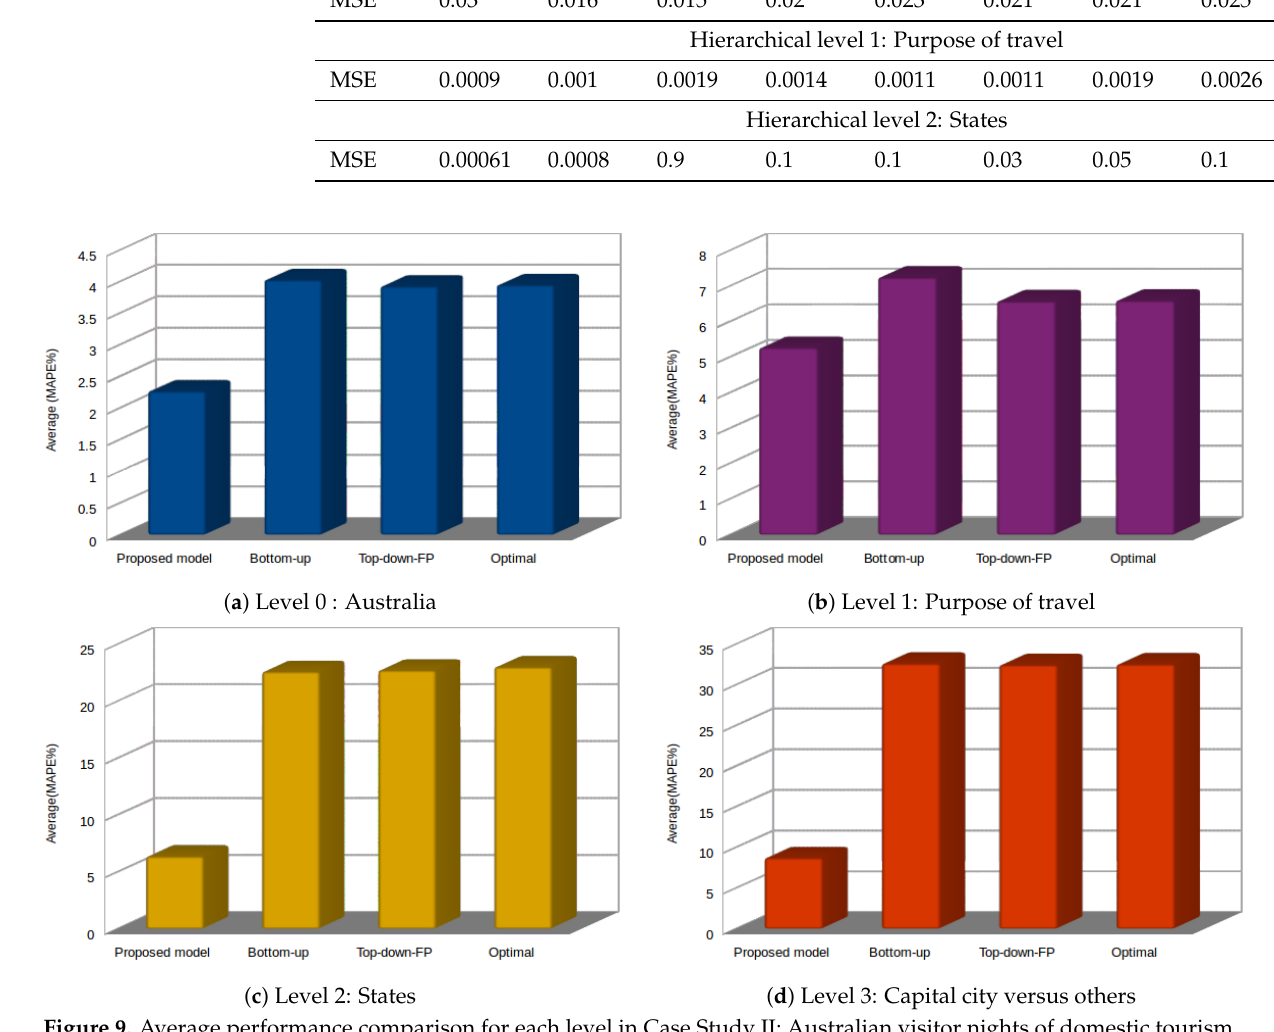
Figure 9. Average performance comparison for each level in Case Study II: Australian visitor nights of domestic